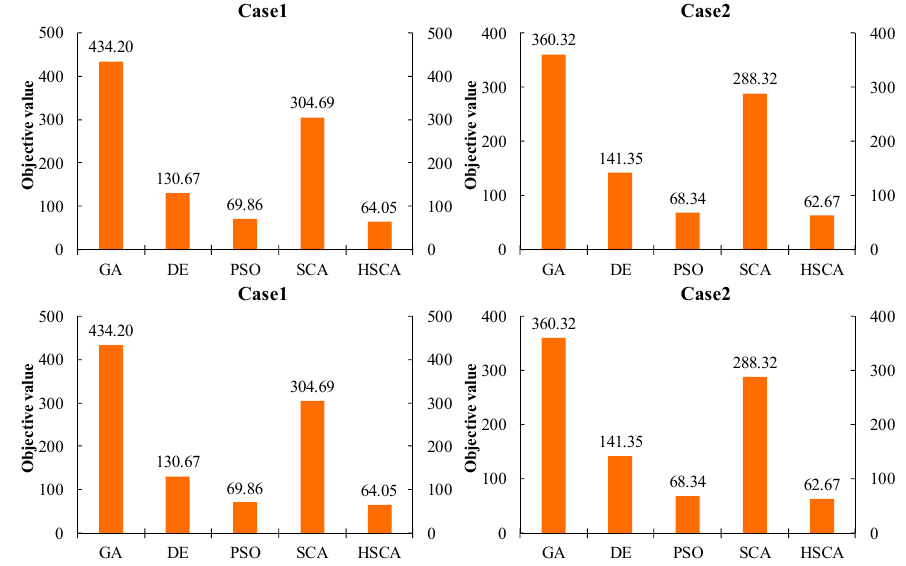
Figure 9. Objective value of five algorithms for the mature hydropower system in four cases.